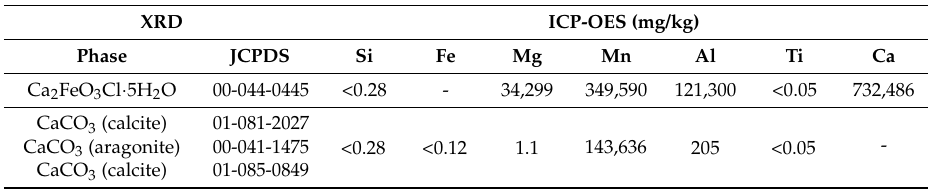
Table 5. Analysis methods and elemental concentrations of the precipitates formed with increasing pH of the filtrate with 20%